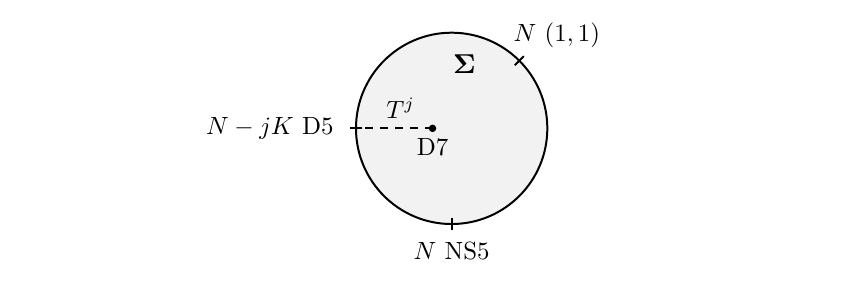
Figure 4 . Disc representation of the supergravity solution corresponding to the T N;K;j junction after moving the constrained groups of 5-branes into the